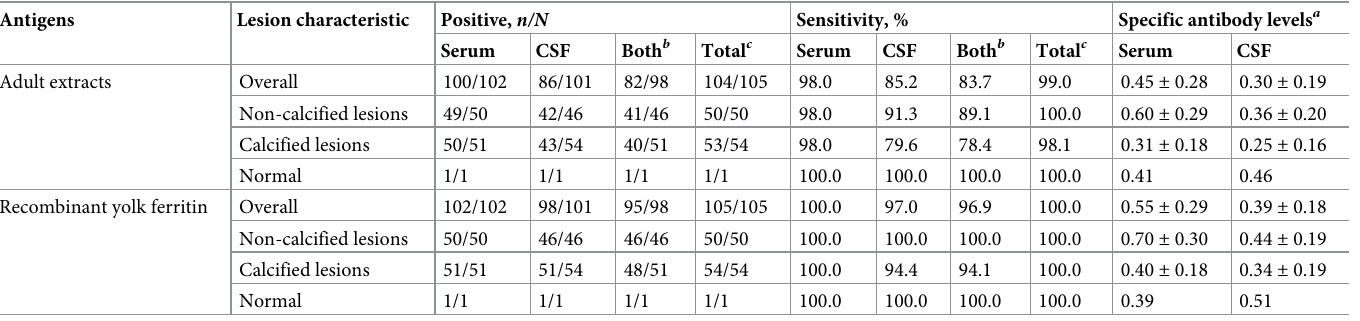
Table 4. Comparison of the diagnostic efficacy of serological biomarkers for cerebral